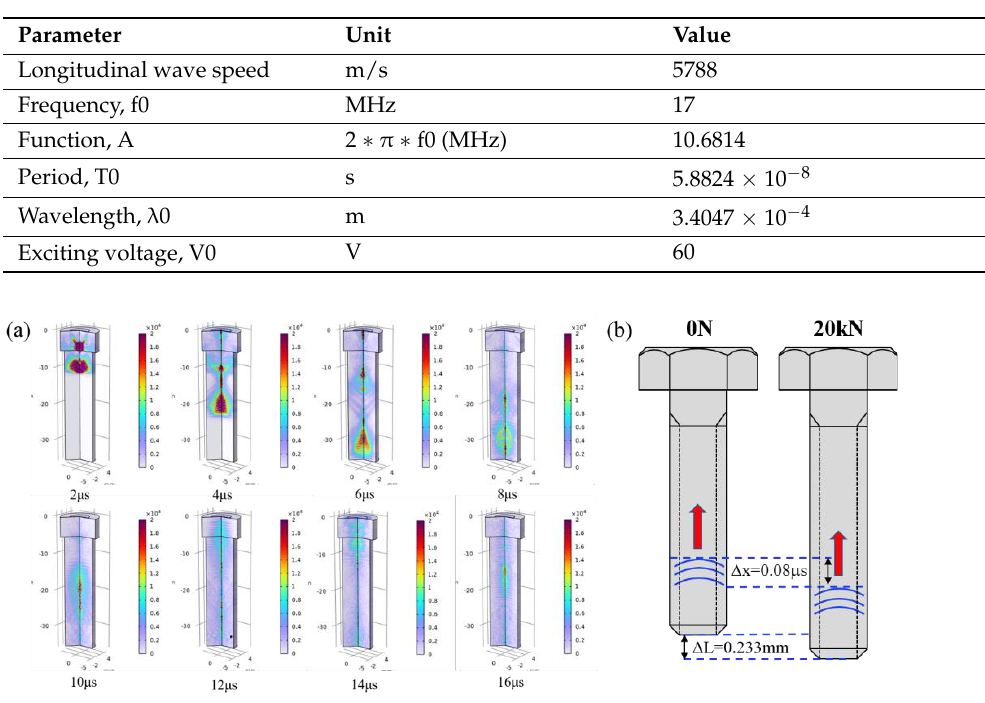
based superalloy bolt, ( b ) schematic −